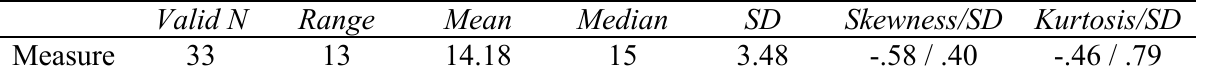
Descriptive Statistics for the MC Test of Pragmatic